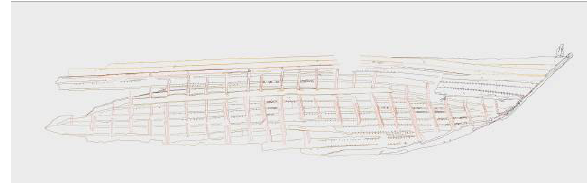
Figure 15. 3D vectorial model of the entire hull.